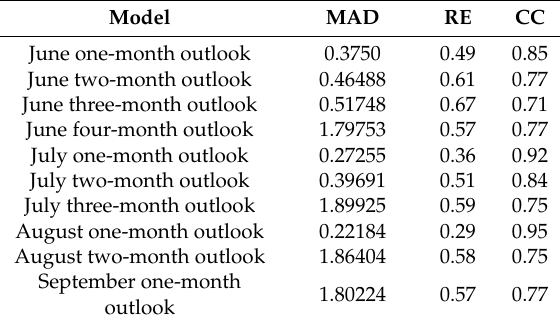
Table 3. Performances of the drought models using the “rules alone” modeling option on the test dataset. Model